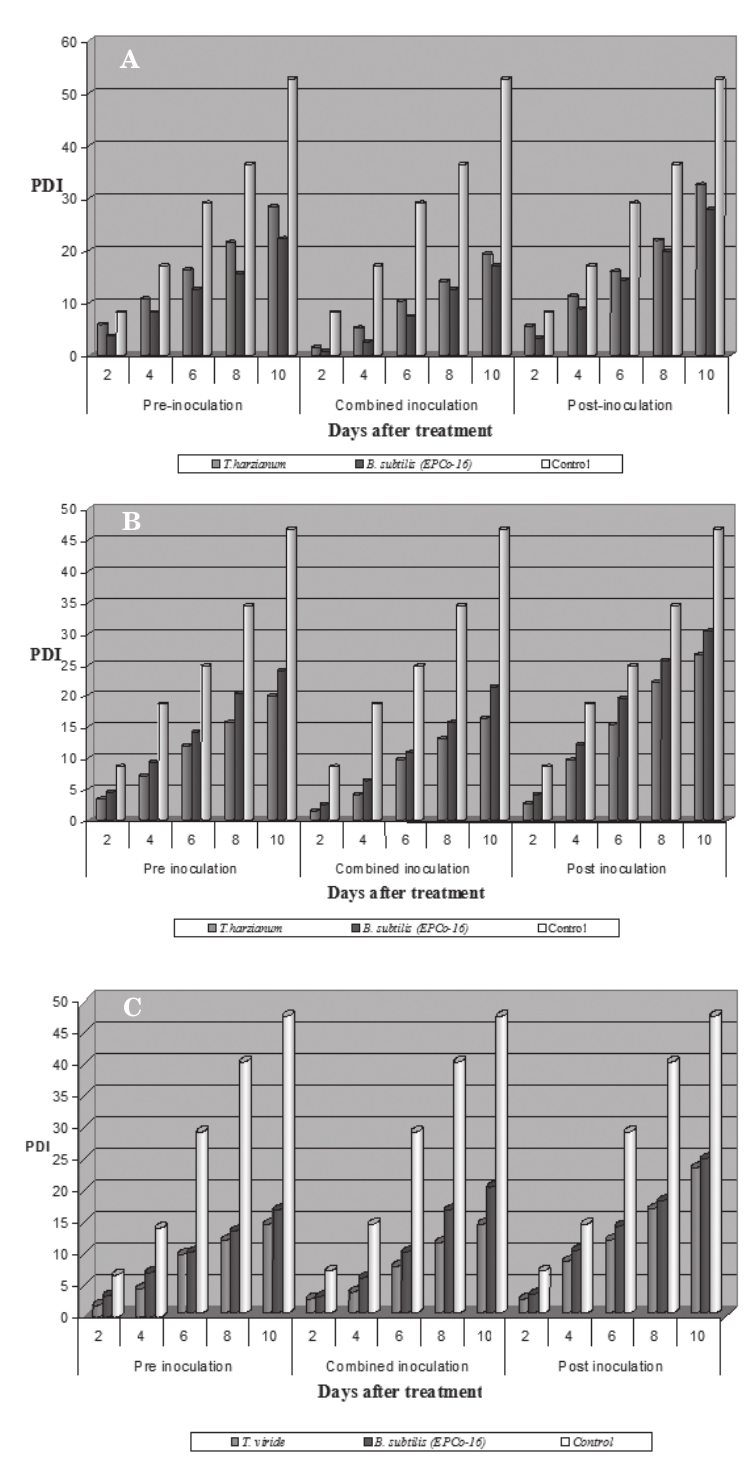
Figure 1. Effect of pre-, combined and post- inoculation of antagonists on the incidence (percent disease index, PDI) of rot caused by: A) Aspergillus carbonarius , B) Penicillium expansum and C) Fusarium moniliforme in